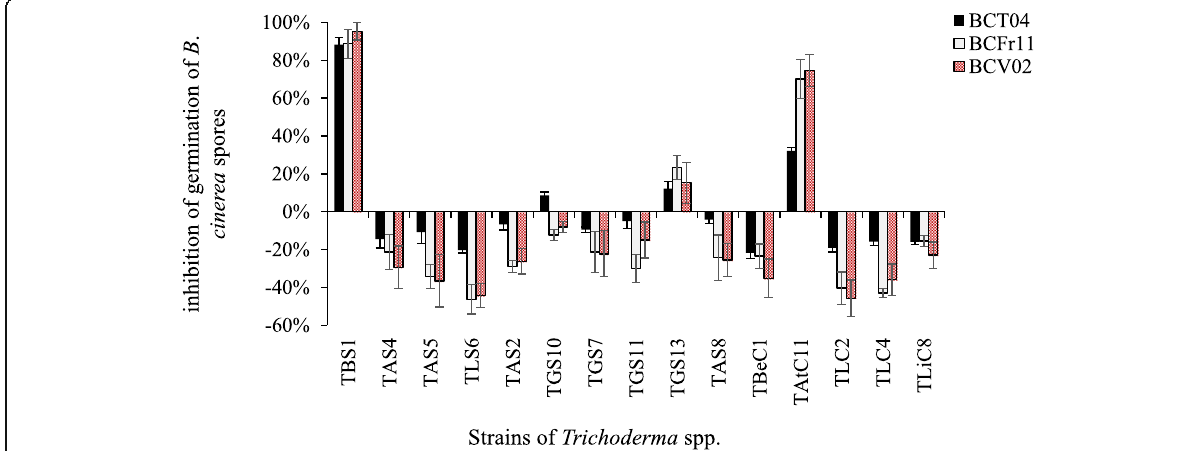
brevicompactum (TBS1) was the most effective isolate for the control of grey mould on tomatoes caused by B.